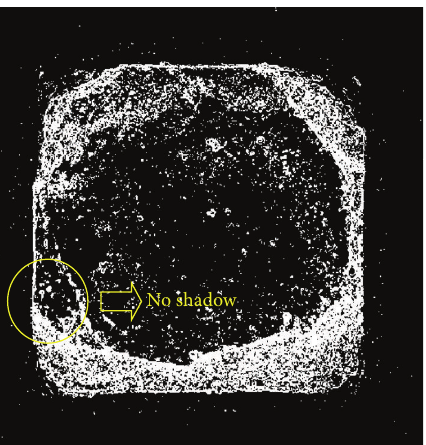
Figure 6: Shadow removal of Type 2 output by standard deviation filter.